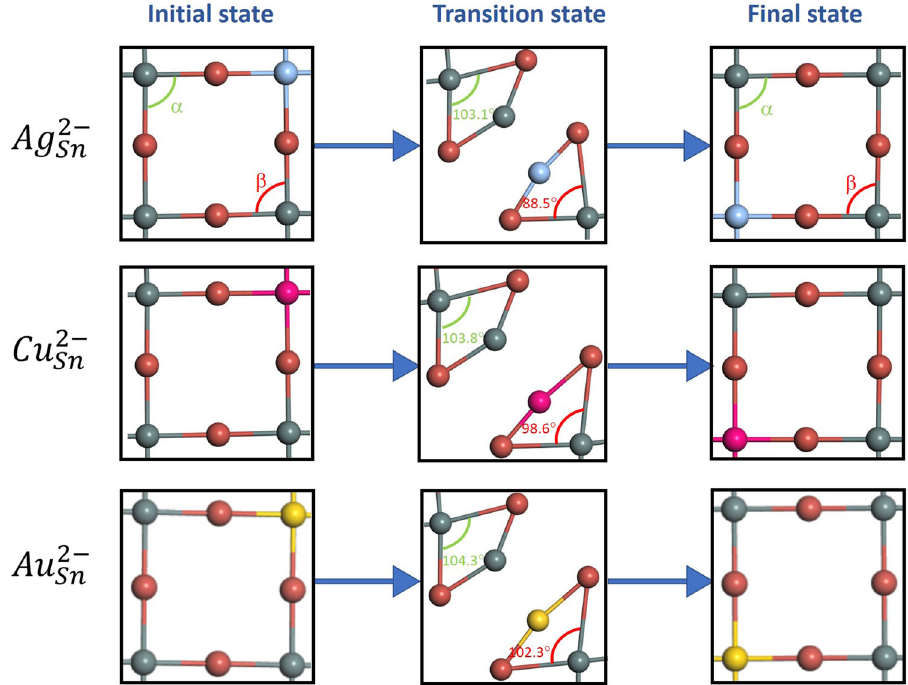
Fig. 4 The diffusion of Sn-site substitutional impurities. The main modes of diffusion for impurities Ag 2 (cid:2) transition, and fi nal states are on the left, middle, and right, respectively. The sizes of the Br-Sn-Br angle α ( β ) in the square planar structures are used to measure the distortion of the structures. The spheres with different colors represent the different elements, yellow- Au , silvery- Ag , pink- Cu , red- Br , and gray- Sn